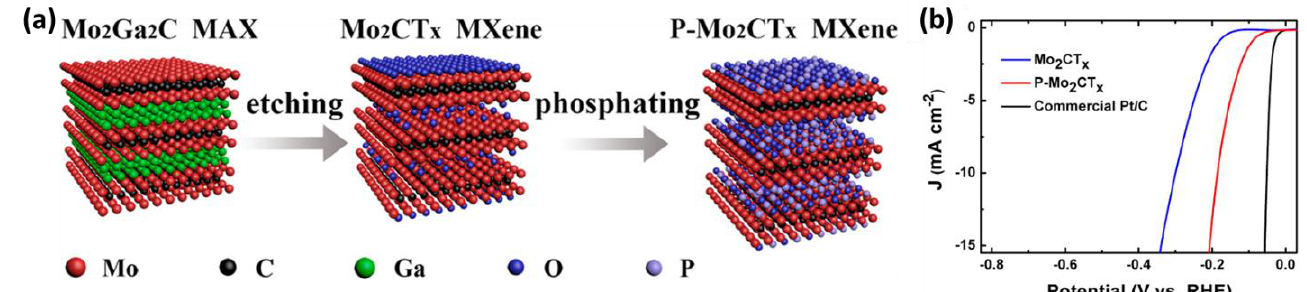
Figure 8. ( a ) Schematic illustration of the preparation of Mo 2 CT x and P−Mo 2 CT x and ( b ) HER polar- ization curves of Mo 2 CT x , P−Mo 2 CT x , and commercial Pt/C (20 wt % Pt). Adapted with permission [68]. Copyright 2018, American Chemical Society.